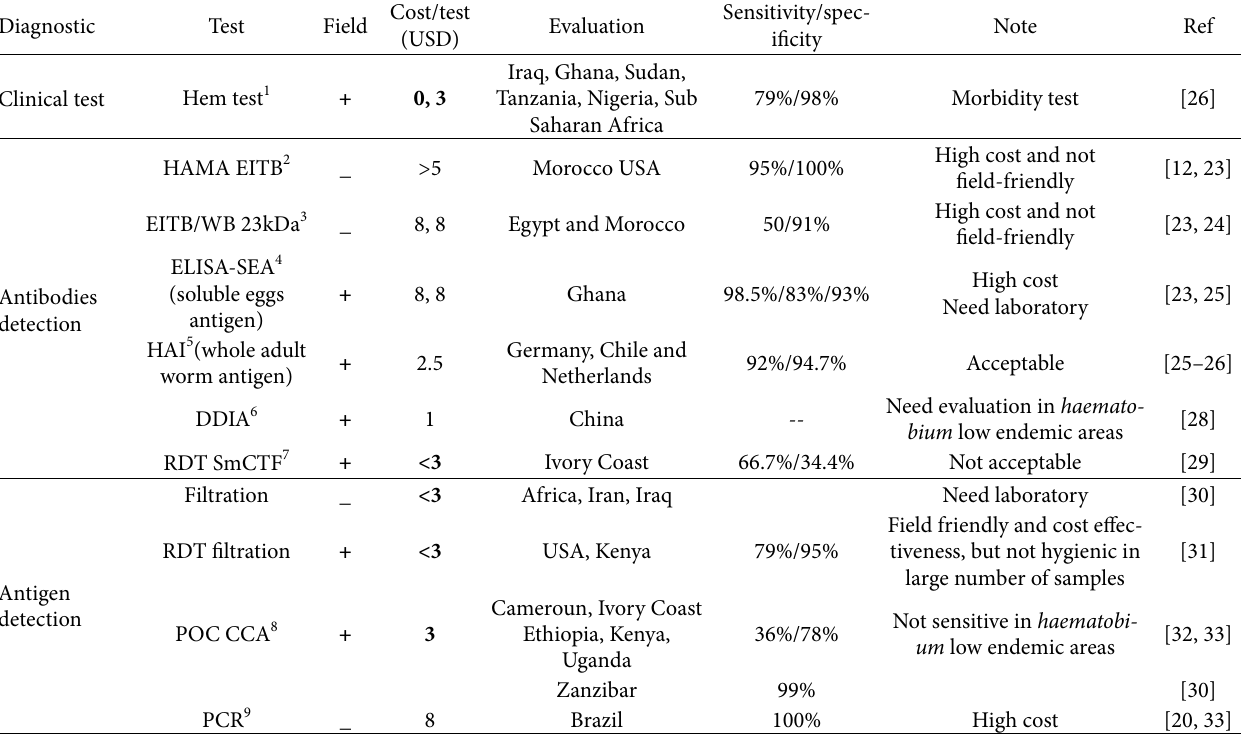
1. Urine hemedipstick, 2. Heamatobium microsomal antigen enzyme Immunotransfert Blot, 3. 23 kDa Western blot, 4. Soluble eggs antigen enzyme linked- immunosorbent assay, 5. Hemmaglutination indirect, 6. Dipstick dye immunoassay, 7. Schistosoma mansoni cercarial transformation fluid, 8. Point of care/ circulating cathodic Antigen, 9. Polymerase chain